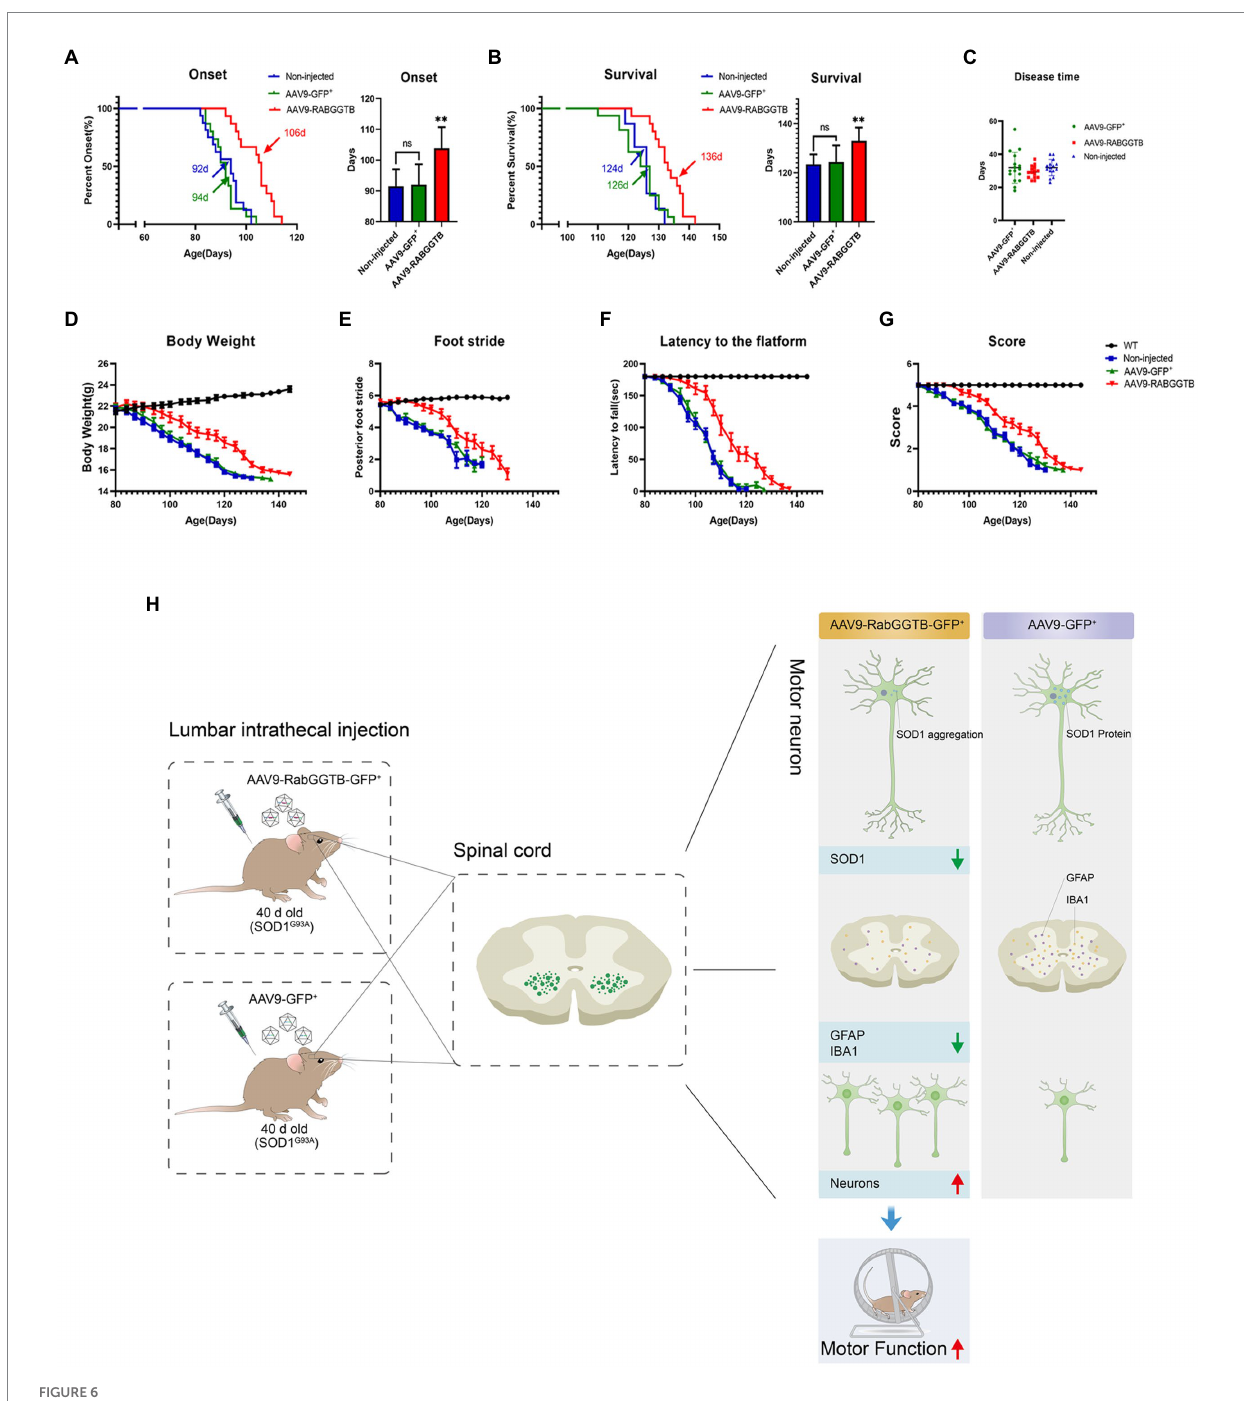
FIGURE 6 Overexpression of RabGGTB in the spinal cord of mice delayed disease onset, extended lifespan, and improved the disease phenotype. Mice were given intrathecal injection of AAV on P40, and behavioral changes were observed on P80. (A) The median disease onset of the treated mice was significantly delayed (non-injected: 92 days; AAV9-GFP + : 94 days; AAV9-RabGGTB-GFP + : 106 days; p < 0.01). (B) The median survival time of the treated mice was also significantly prolonged (non-injected: 124 days; AAV9-GFP + : 126 days; AAV9-RABGGTB-GFP + : 136 days; p < 0.01). (C) However, overexpression of RabGGTB did not prolong the course of disease in mice (non-injected: 32 days; AAV9-GFP + : 31 days; AAV9-RabGGTB-GFP + : 30 days; p > 0.05). (D) The body weight curves of WT and SOD1 G93A mice non-injected or injected with AAV9-GFP + or AAV9-RabGGTB-GFP + . RabGGTB overexpression delayed the decrease of body weight in mice. (E–G) The SOD1 G93A mice overexpressing RabGGTB performed better on rotation tests, gait analysis tests, and neurological function evaluation compared with their untreated littermates. (H) Schematic diagrams of the results. The onset time was measured using the rotarod test. The end- stage was defined as the loss of the righting reflex, whereby a mouse cannot correct its body position within 30 s when placed on its side. Data represent the mean ± SEM, n = 15 or 16 mice per group; p -values were determined using one-way ANOVA, Error bars denote the SEM. * p <0.05, ** p <0.01, *** p <0.001. ns: no